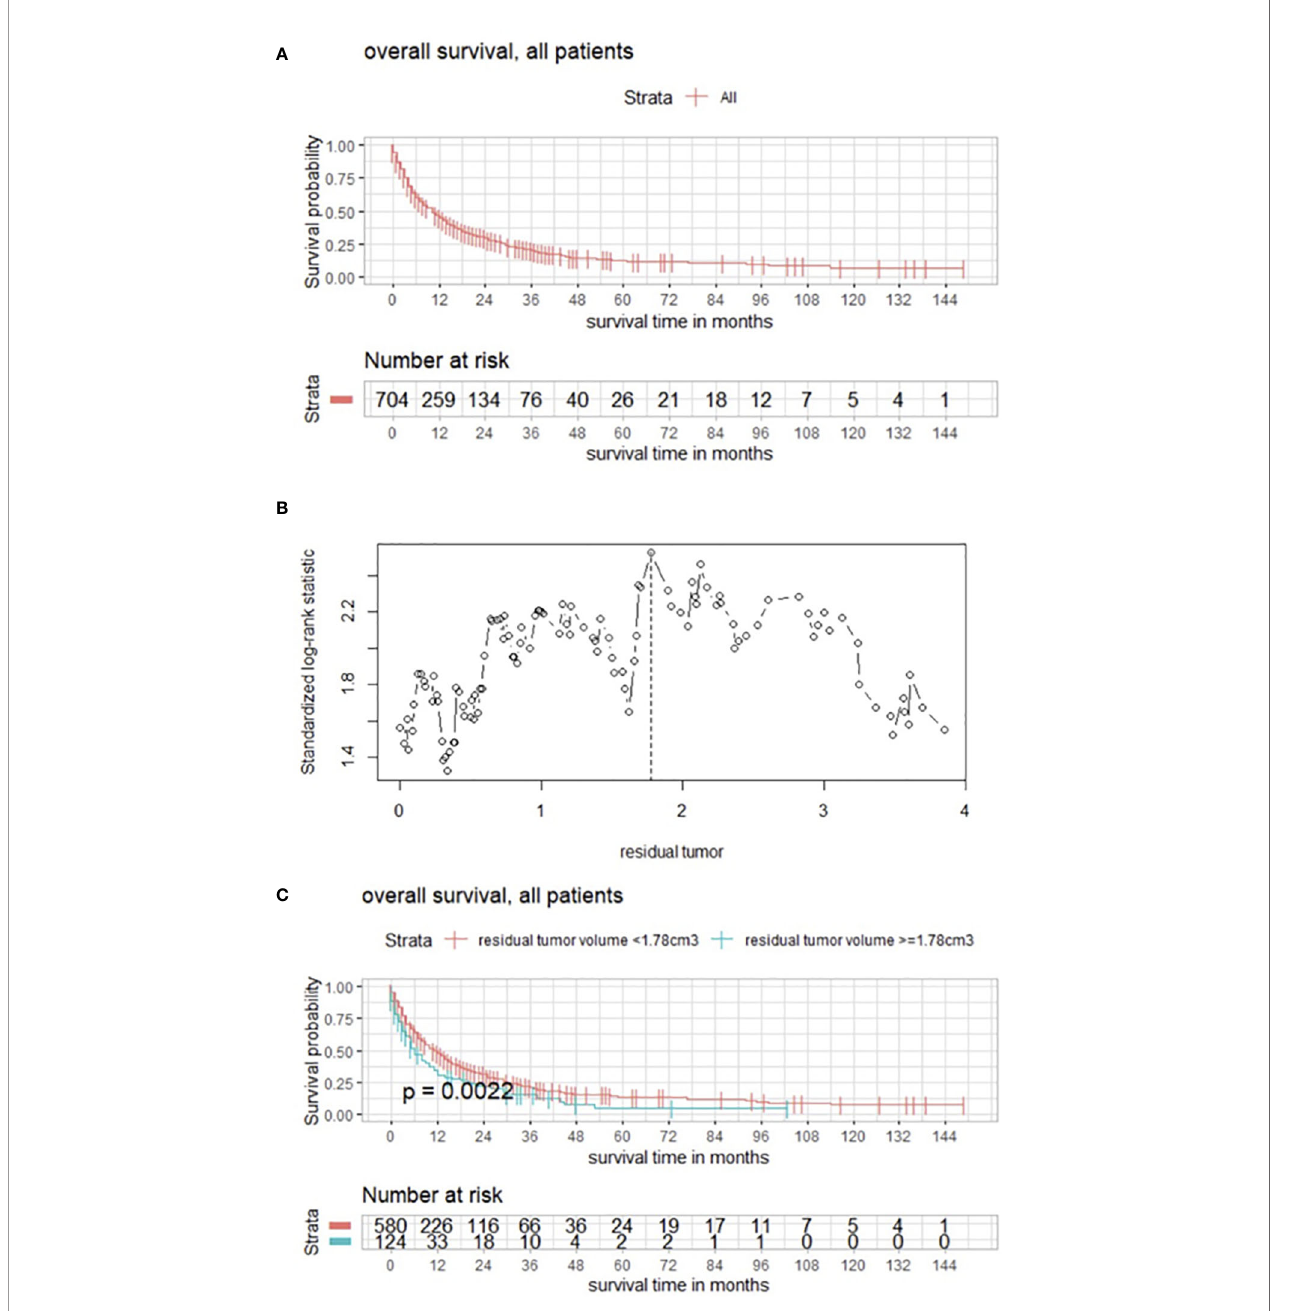
FIGURE 1 | (A) Overall survival of patients with BMs modeled by Kaplan – Meier estimator. (B) Maximally selected log rank statistics displaying the cutoff of postoperative RTB regarding overall survival in patients with BMs. (C) Functions of overall survival in all patients for subgroups of cutoff residual tumor demonstrating signi fi cantly divergent survival